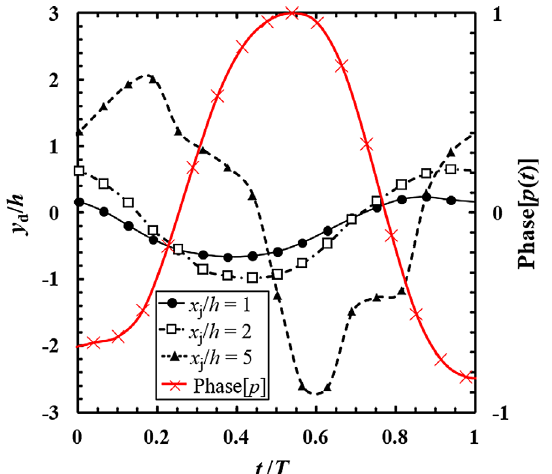
Figure 17. Periodical variations of jet at the edge ( x j / h = l / h )